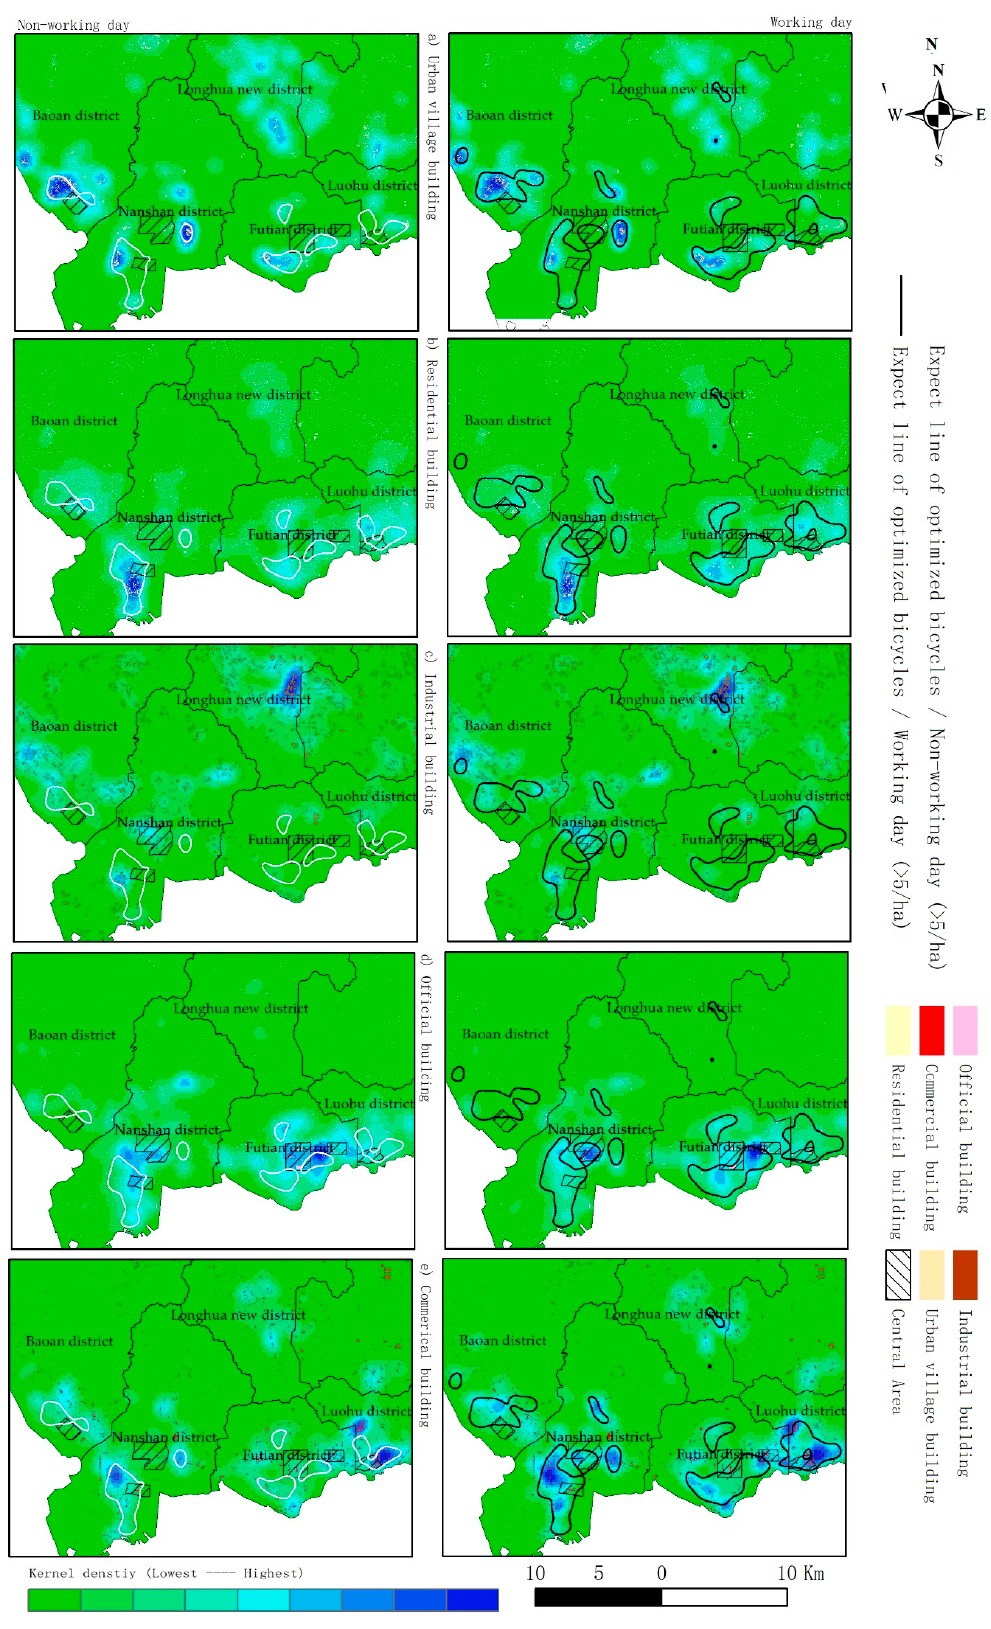
Figure 10. Spatial distribution of optimized bikes near di ff erent